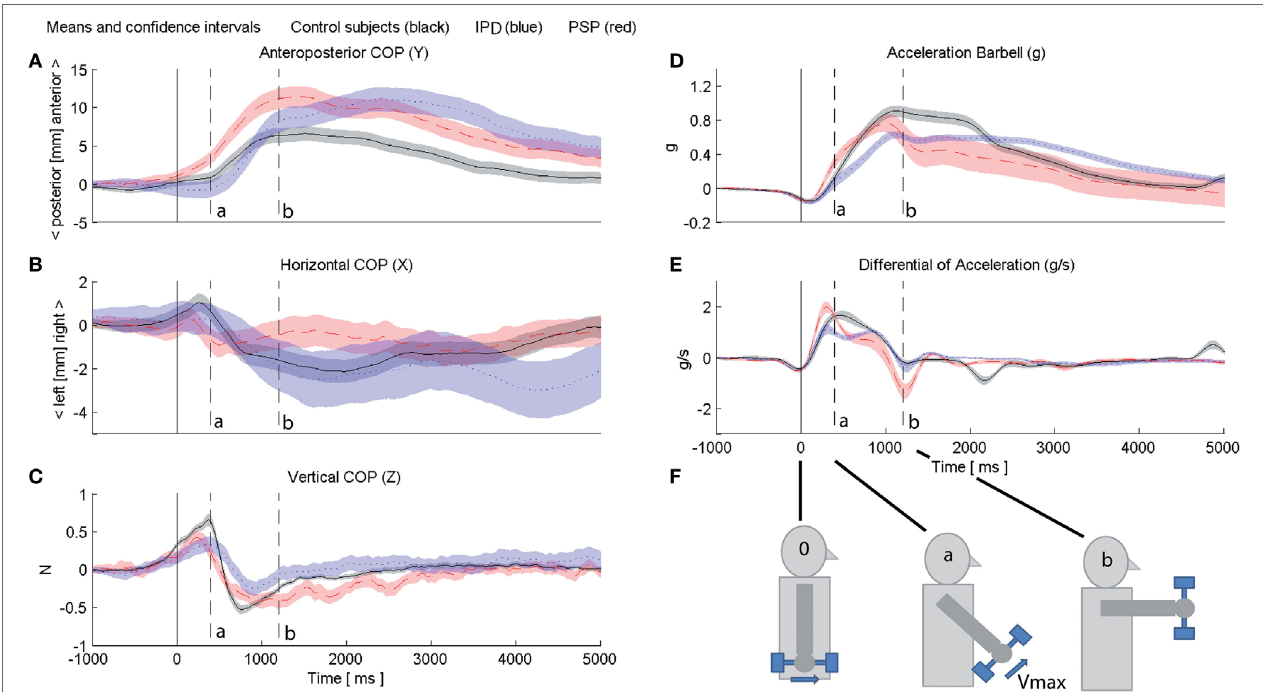
FigUre 1 | Subjects’ center of foot pressure (COP) depicted for control subjects (black), idiopathic Parkinson’s disease (IPD) (blue), and progressive supranuclear palsy (PSP) (red) with 95% confidence intervals (opaque area of according color) in sagittal (a) , lateral (B) , and vertical (c) directions. Data of all individuals of one respective group are segmented and averaged 1,000 ms prior to the weight lifting onset and 5,000 ms beyond. An accelerometer inside the weight indicated the course of the fast 90° quarter angle motion (position indicated in (D) at 0-g hanging down; forward 90° holding applies 1-g gravitational pull); (e) depicts weight angular velocity as derivative of (D) . Weight lifting onset is at “0.” The peak angular velocity of controls is reached at marker ”a,” the 90° forward position of the weight in controls is reached at marker “b.” Markers “0,” “a” and “b” are depicted continuously throughout (a–e) . (F) provides a schematic of the barbell motion for